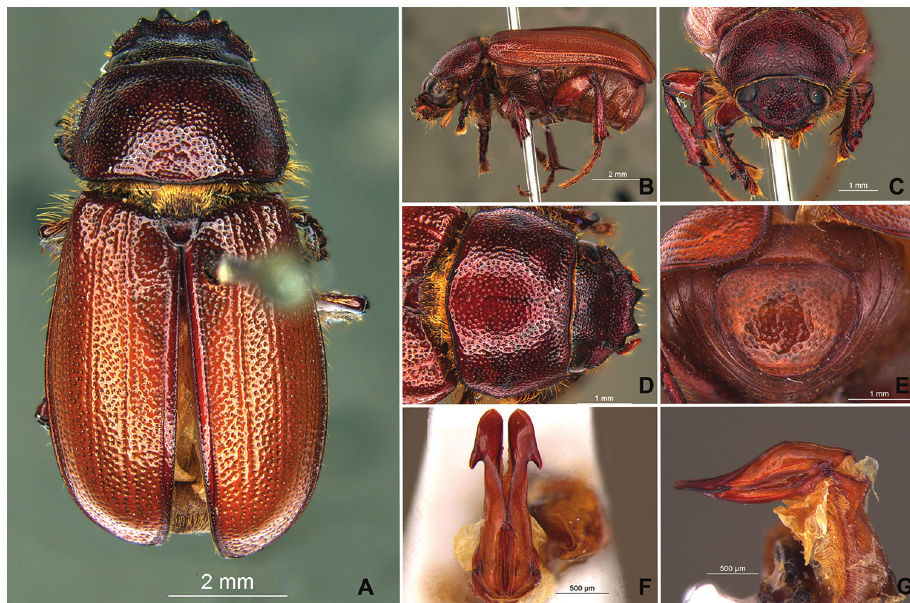
Figure 81. Liogenys piauiensis Cherman, sp. n. A Dorsal view B Lateral view C Frontal view D Clypeus and pronotum E Pygidium F Parameres, dorsal view G Parameres, lateral view. on the anterior margin; mesotibia sub-quadrate in cross section; disc coarsely sculp- tured, two mesotibial transverse carinae, the apical incomplete; metacoxa, scarcely bristled and finely punctured on the anterior or posterior margins, smooth on the metacoxal disc; basal apophysis of metacoxa produced beyond the outer margin of trochanter; inner margin of metatibia carinated towards apex, apical inner surface se- tose; metatibial disc finely sculptured; metatibial transverse carina present posteriorly and with posterior discontinuous longitudinal carina; metatibial apical spurs of dif- ferent lengths, the longest one equal to the diameter of the tibial apex; protarsomere II long; pro- and mesotarsomeres I to IV enlarged, protarsomeres slightly wider than the mesotarsomeres; less than two-fold wider than metatarsi; the basal metatarsomere shorter and slightly wider than tarsomere II; claw bifid, symmetrical, superior tooth longer and narrower than the inferior; distance between teeth shorter than the infe- rior tooth. Abdomen : ventrites with few sparse bristles on disc; propygidium hidden by the elytra; pygidium convex, sub-quadrate, as wide as it is long; pygidial width exceeding distance between spiracles of propygidium; pygidial disc glabrous, bristled at the margin of the apex; very shiny, wrinkled, coarsely punctured; pygidial apex in males sub-quadrate. Parameres: basal region wider than the parameres together at its transverse midline; parameral split at the third portion; total length of parameres near three times the length of their apex; slightly narrowed medially; inner margins of parameres convergent; apex harpoon-like with lateral angle projecting straight down- ward (Fig. 81F). In lateral view parameres concave (Fig.